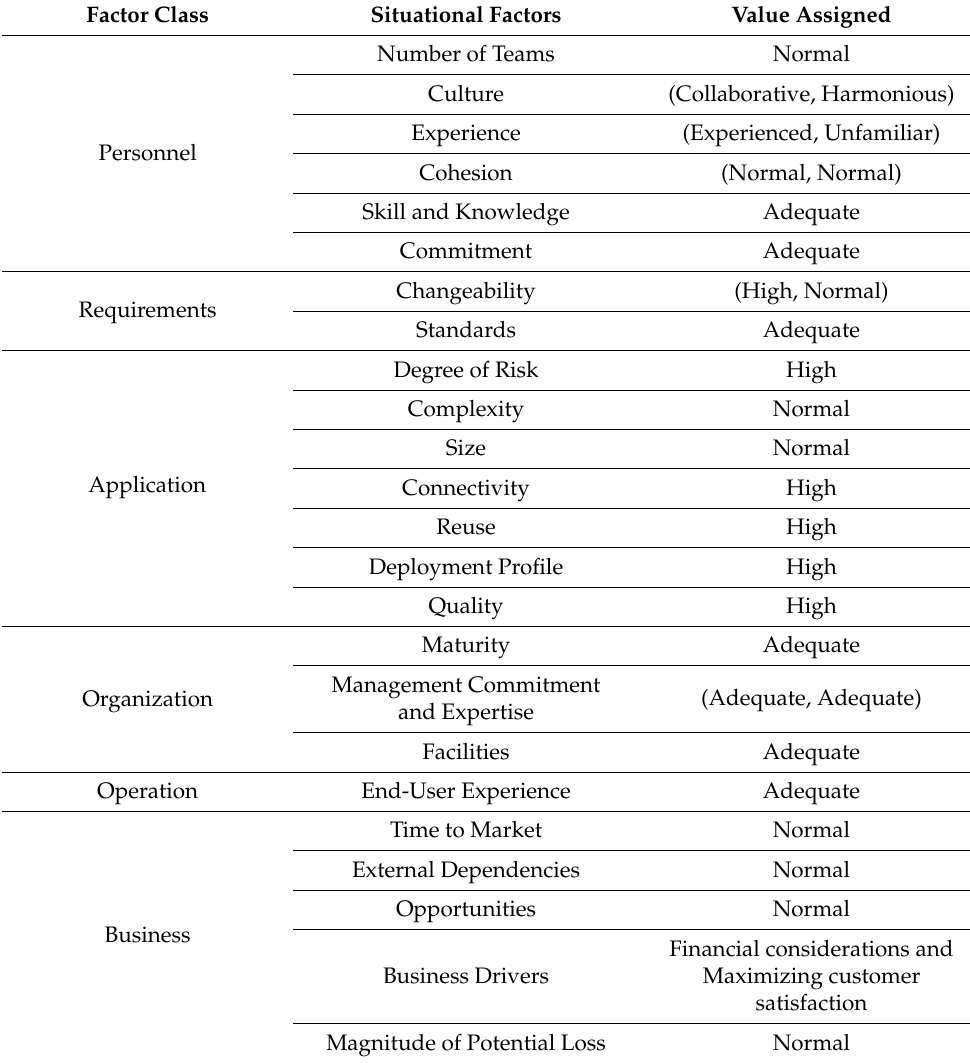
Table A5. Values of context attributes in project